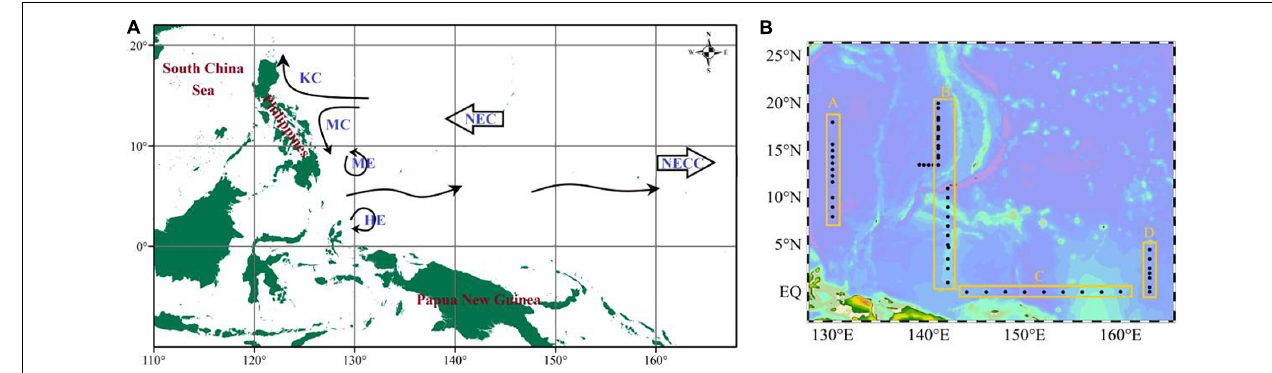
FIGURE 1 | Schematic showing the circulations (A) and sampling stations (B) for the cruise WPO. KC, Kuroshio current; MC, Mindanao current; ME, Mindanao Eddy; HE, Halmahera Eddy; NEC, North Equational current; NECC, North Equational counter